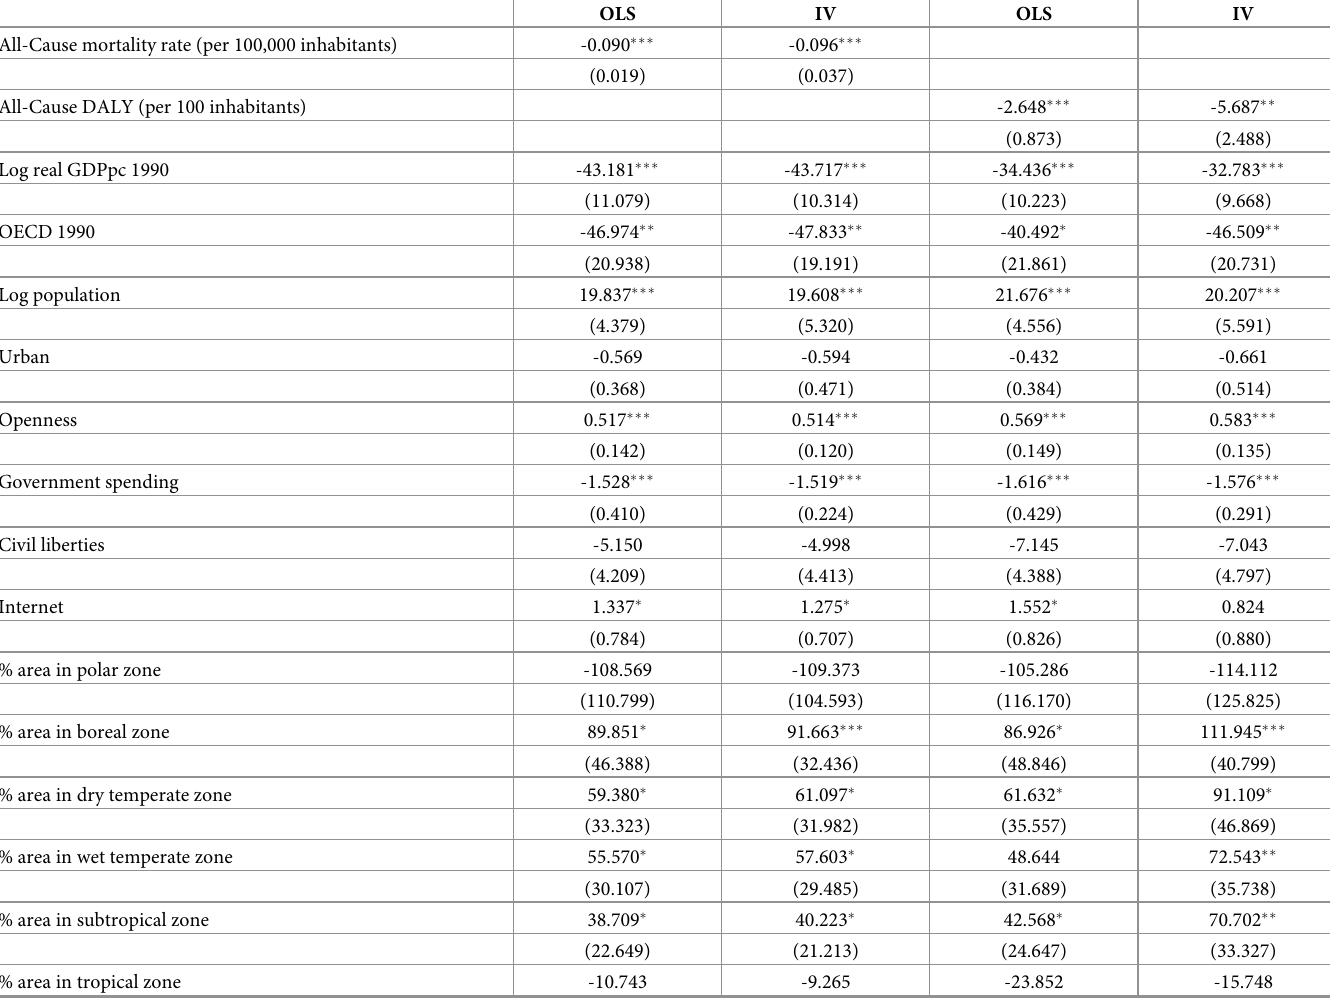
Table A1. The effect of mortality and DALY on GDPpc growth. Long-Run Growth Regression (full specification reported). OLS IV OLS